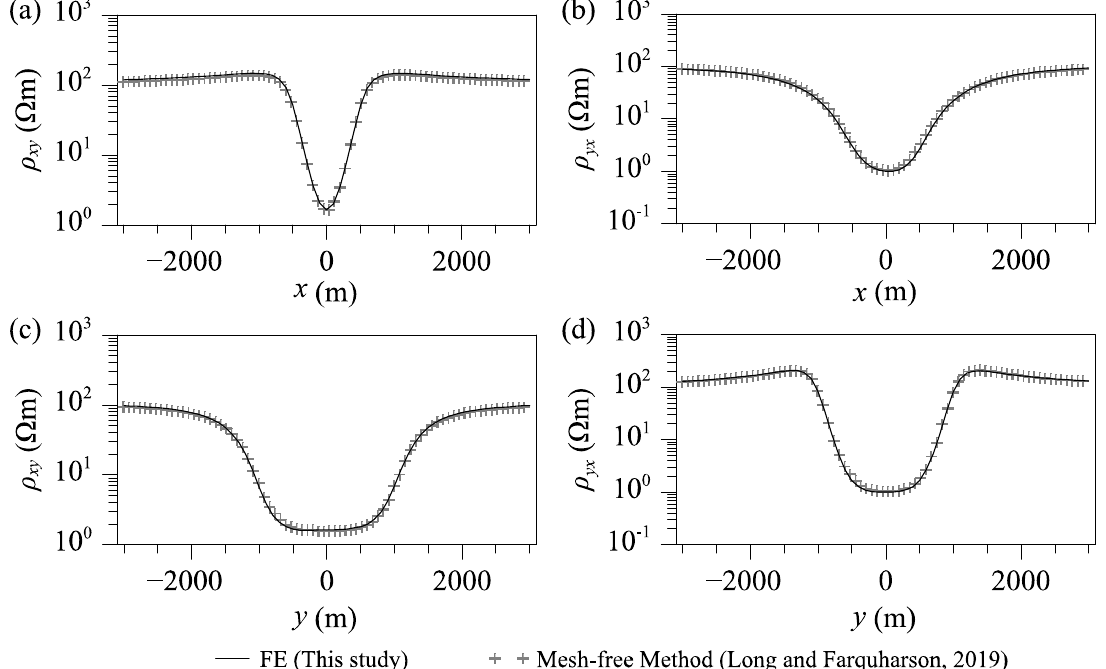
Figure 3. The apparent resistivities of 0.1 Hz for the COMMEMI 3D-1A model. ( a , b ) are for ρ xy and ρ yx for the x -directed survey line, respectively. ( c , d ) are for ρ xy and ρ yx for the y -directed survey line, respectively.